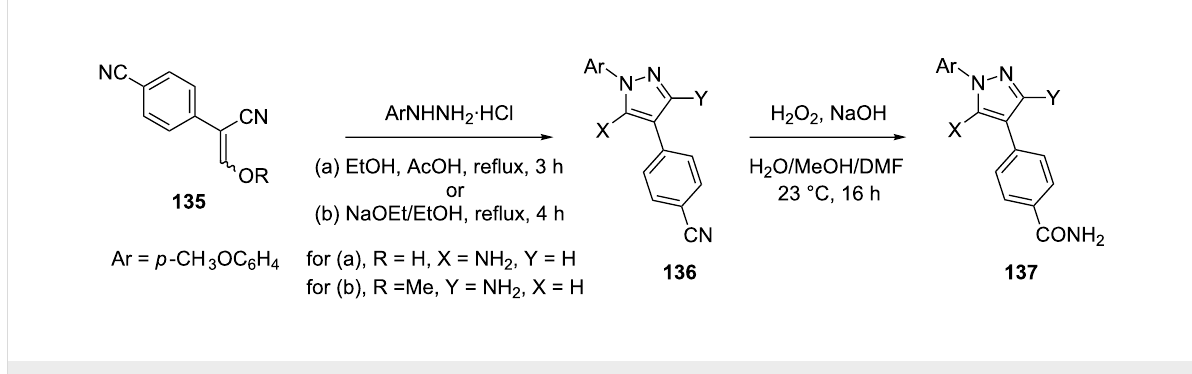
Scheme 37: Synthesis of inhibitors of hsp27-phosphorylation and TNFa-release.